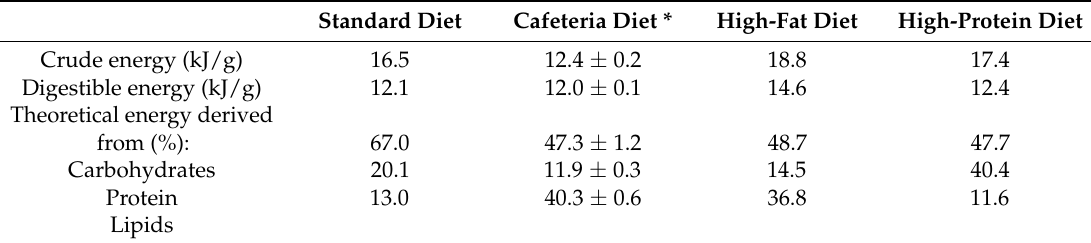
Table 1. Diet energy and macronutrients